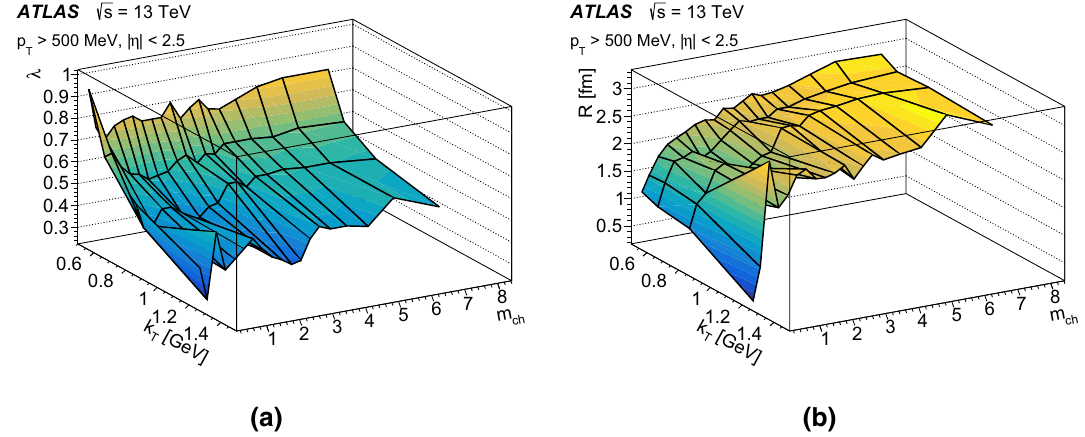
Fig. 12 The two-dimensional dependence on m ch and k T for p T > 500 MeV for a the correlation strength, λ , and b the source radius, R , obtained from the exponential fit to the R 2 ( Q ) correlation functions using the MB sample for m ch ≤ 3 . 08 and the HMT sample for m ch > 3 . 08